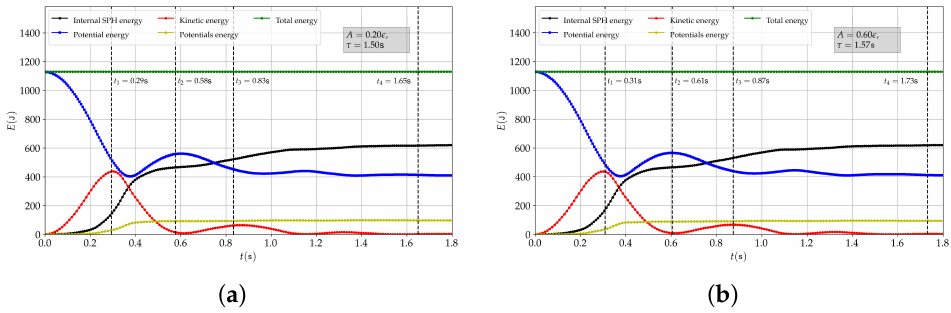
Figure 32. Time evolution of the components of the energy budget for the column collapse case. Viscoelastic response obtained by using (cid:101) CS = 1 × 10 − 4 and two values for (cid:101) Soft . Simulation settings: µ = 1 × 10 − 3 , c = 10.0, ν artf = 0.8, ρ =1 × 10 3 , h = 5.25 × 10 − 2 , ∆ L = 2.5 × 10 − 2 , π 2 = 9.9 × 10 2 . ( a ) (cid:101) Soft = 0.2 (cid:101) CS . ( b ) (cid:101) Soft = 0.6 (cid:101) CS